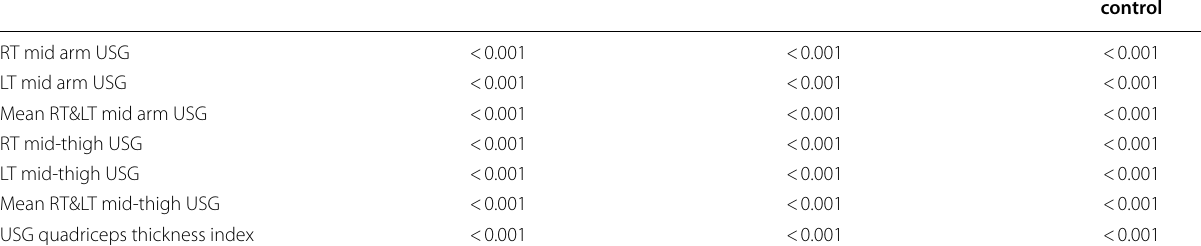
Posthoc pairwise comparison ( P value between each 2 groups)